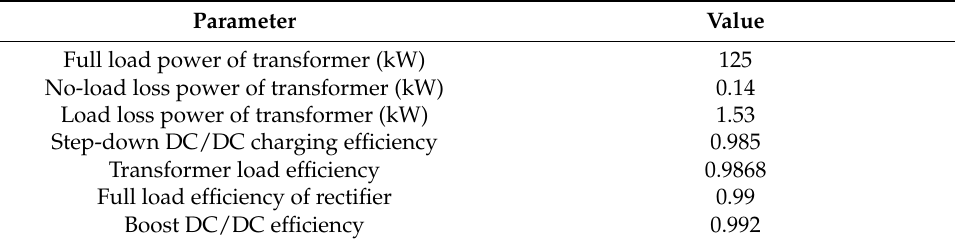
Table 5. The devices parameters of the charging